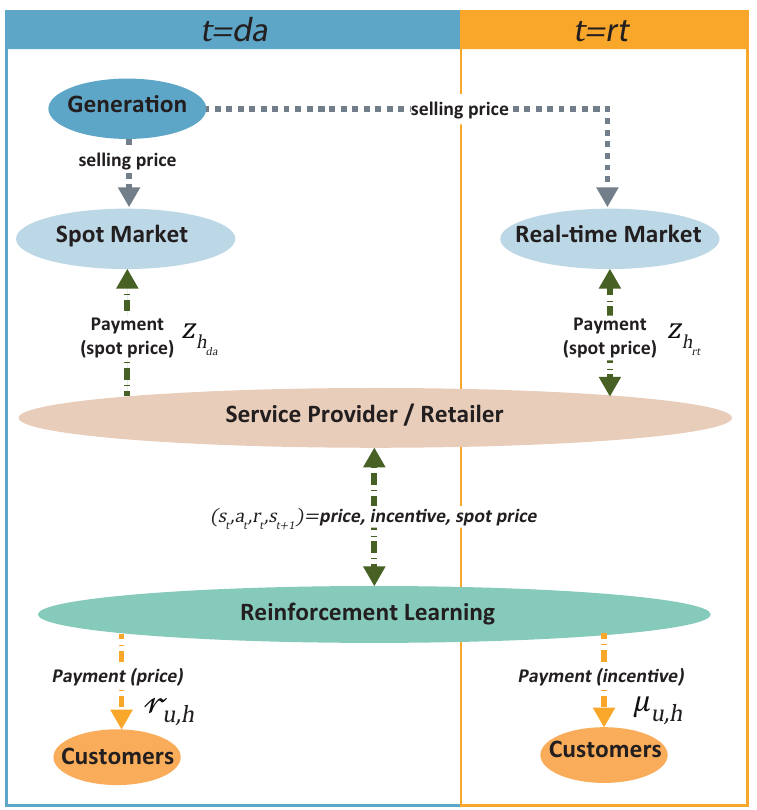
Figure 3. Temporality of the proposed